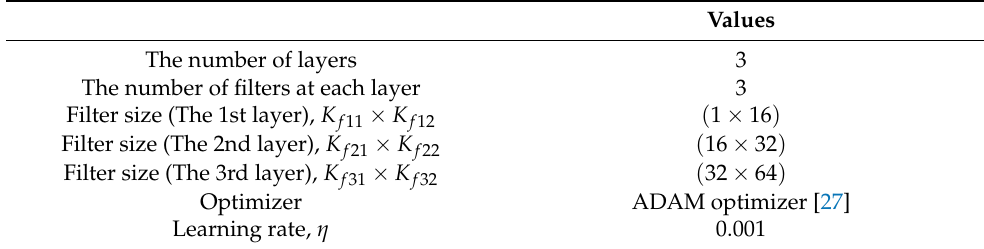
Table 1. The values for the hyperparameters of the CNN module for handwriting character recognition. Values The number of layers 3 The number of filters at each layer 3 Filter size (The 1st layer), K f 11 × K f 12 ( 1 × 16 ) Filter size (The 2nd layer), K f 21 × K f 22 ( 16 × 32 ) Filter size (The 3rd layer), K f 31 × K f 32 ( 32 × 64 ) Optimizer ADAM optimizer [27] Learning rate, η